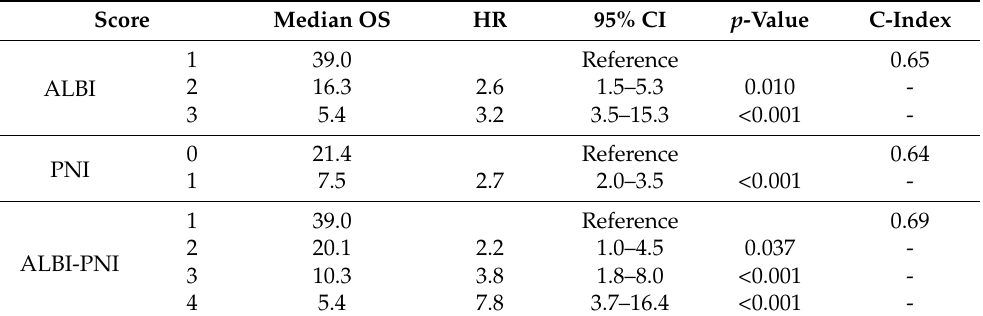
Table 3. Head-to-head comparison of the ALBI grade alone, the PNI alone, and the combination of both.